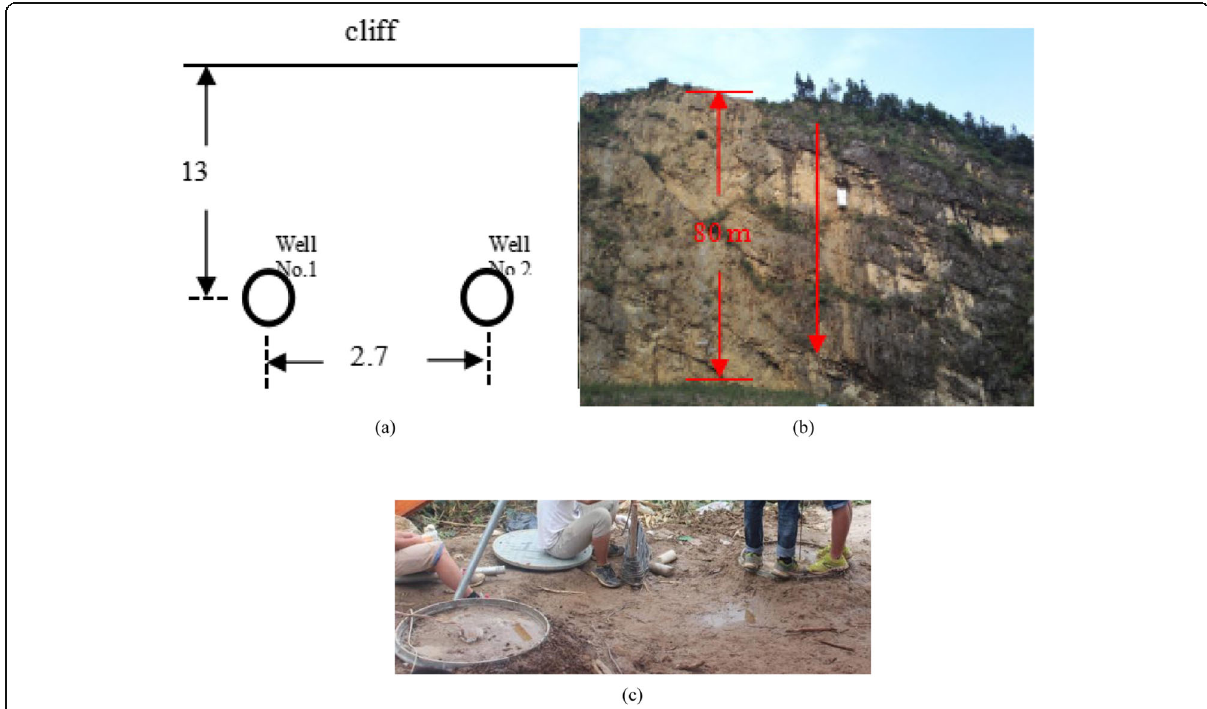
Fig. 14 Borehole diagram. a Borehole position diagram. b Cliff height and borehole relative position. c Wellhead field